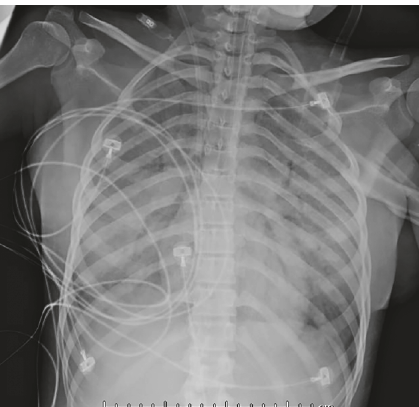
Figure 1: Chest radiograph showing diffuse dense bilateral airspace opacification with lower lobe predominance compatible with pul- monary